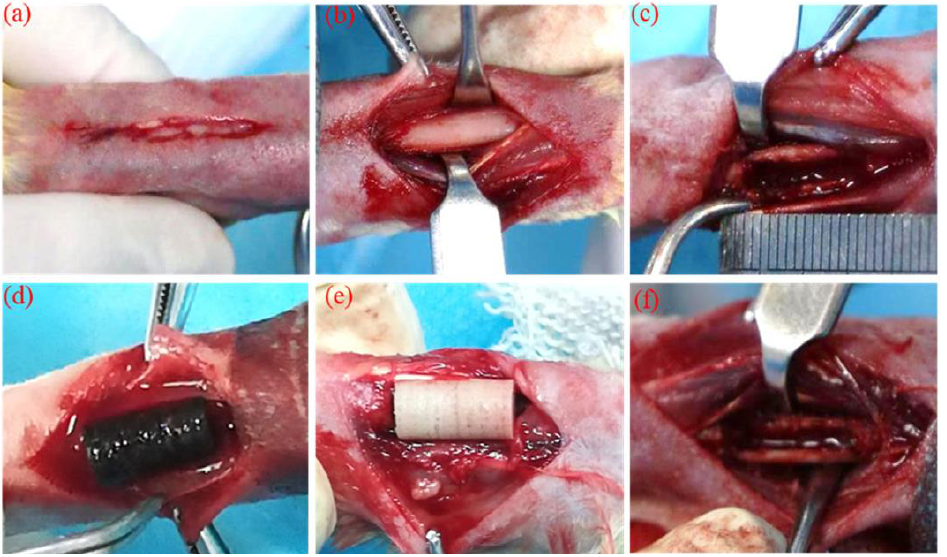
Figure 14. Surgical intervention for scaffold insertion into a bone defect and its steps: ( a ) skin incision; ( b ) rabbit radial diaphysis; ( c ) setting of the bone defect; ( d ) scaffold insertion; ( e ) bone defect with scaffold; ( f ) bone defect without scaffold [96]. Reprinted from [96], Copyright (2023), with permission from Elsevier.